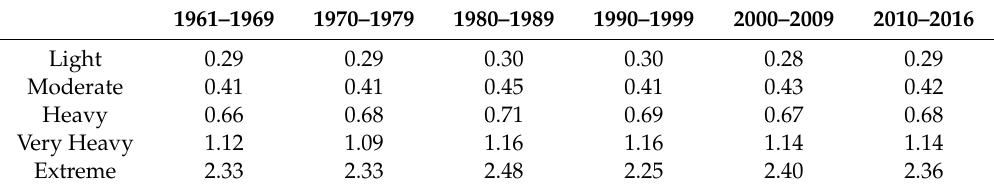
Table 3. Interannual variation of CV of rainy